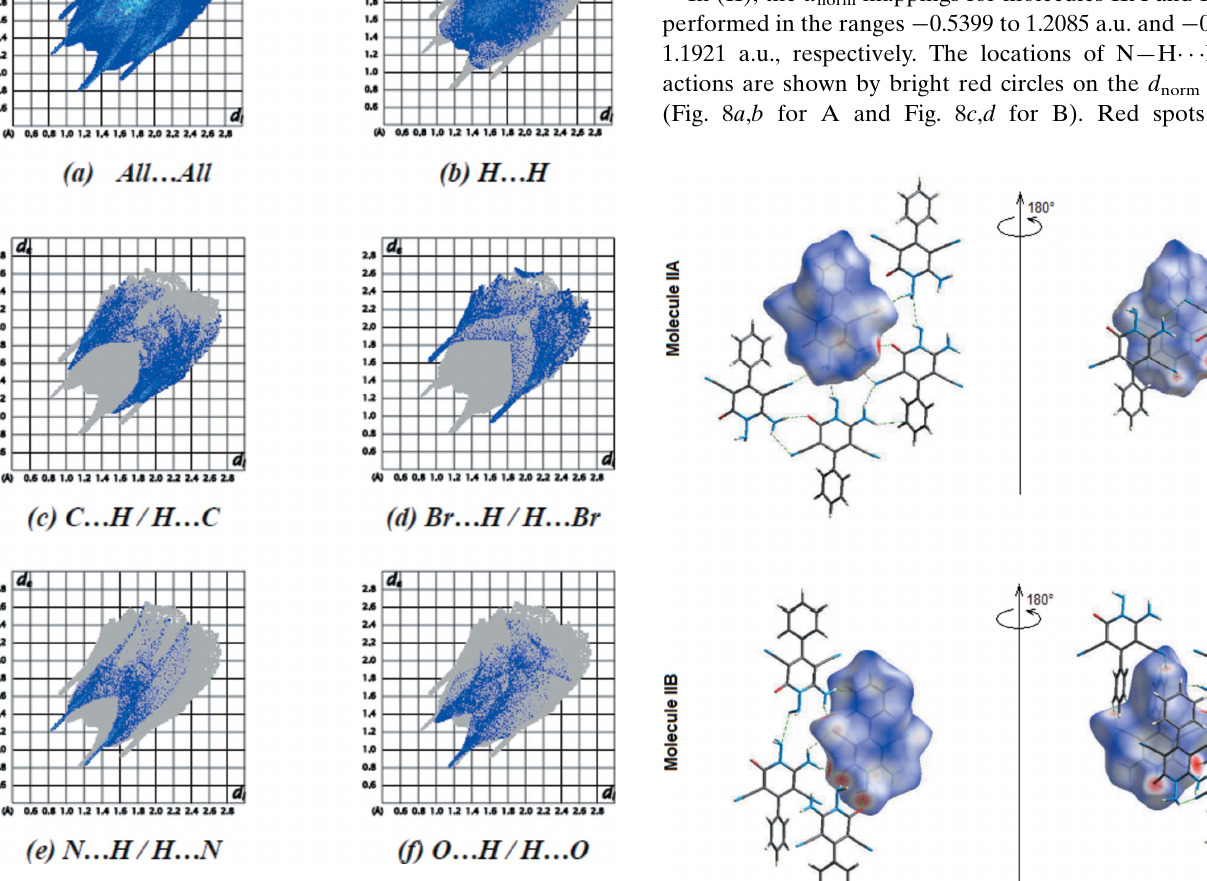
Figure 7 The two-dimensional fingerprint plots of (I), showing all interactions ( a ), and those delineated into H (cid:2)(cid:2)(cid:2) H ( b ), C (cid:2)(cid:2)(cid:2) H/H (cid:2)(cid:2)(cid:2) C ( c ), Br (cid:2)(cid:2)(cid:2) H/H (cid:2)(cid:2)(cid:2) Br ( d ), N (cid:2)(cid:2)(cid:2) H/H (cid:2)(cid:2)(cid:2) N ( e ) and O (cid:2)(cid:2)(cid:2) H/H (cid:2)(cid:2)(cid:2) O ( f ) interactions. The d i and d e values are the closest internal and external distances (in A˚ ) from given points on the Hirshfeld surfaces.